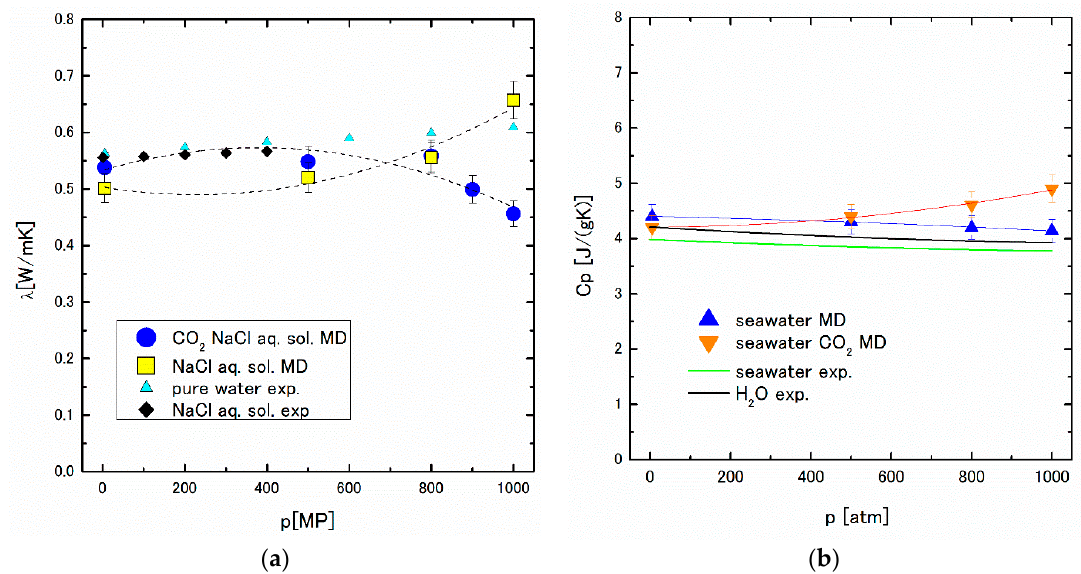
Figure 5. ( a ) The pressure dependence of the thermal conductivity; ( b ) The pressure dependence of the specific heat at the constant pressure. In ( a , b ), the horizontal axes show pressure. The abbreviates “aq.”, “sol.”, “exp.” stand for “aqueous”, “solution”, and “experiment”, respectively. The dotted lines in ( a ) and the orange and blue lines in ( b ) are drawn to guide the reader’s eyes.